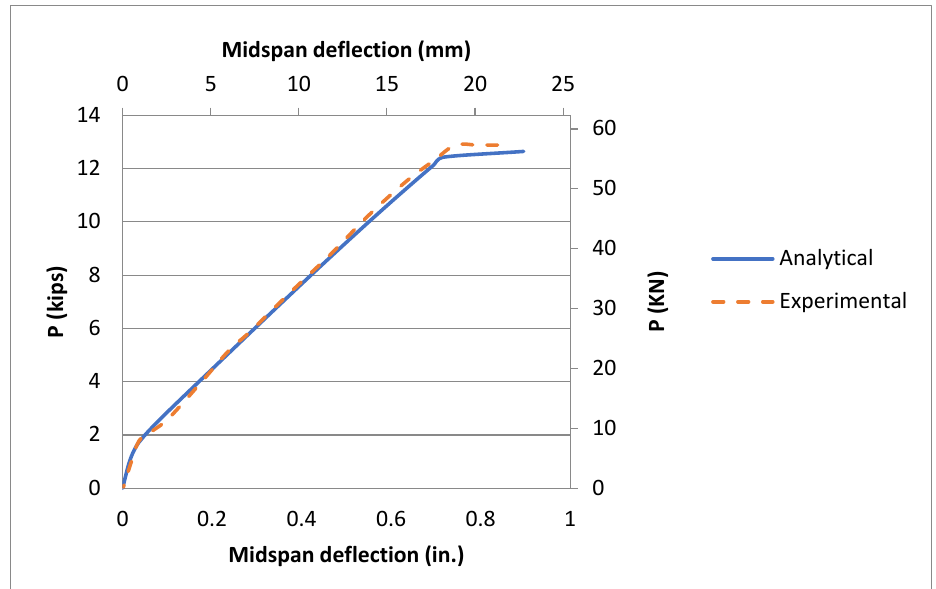
Figure 23. Almusallam (1997) [19] load vs. midspan deflection comparisons.